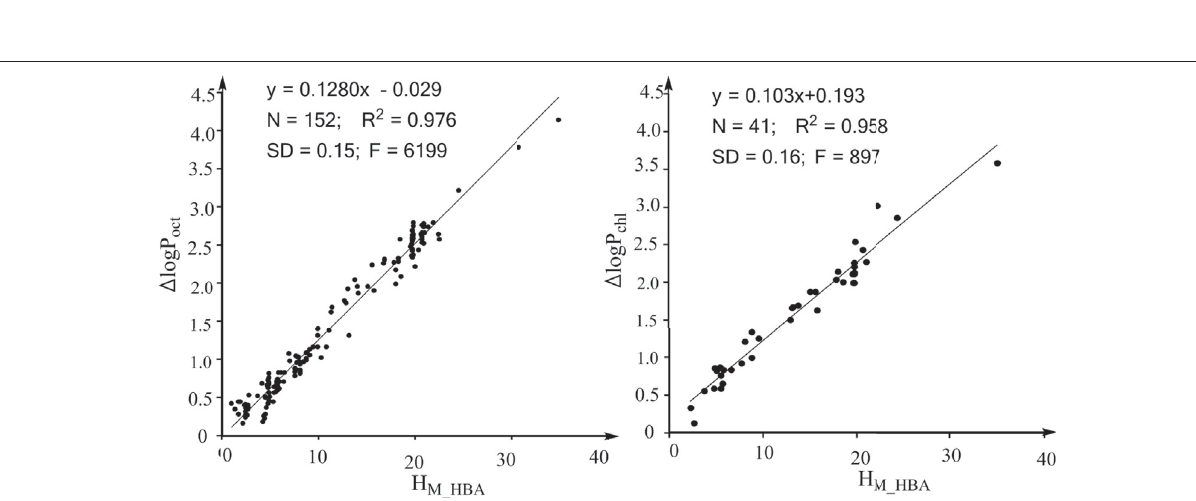
FIGURE 1 | Correlations between the molecular descriptor S m and the effects of molecular size on various properties. (A) Linear associations between logP 16 / logP oct and S m for alkanes. (B) Linear association between logK brain (log of the partition coef fi cient from air to human brain) and S m for nonpolar compounds. (C) Plot of the water to hexadecane phase-transferring free energy for depolarized solutes ( Δ G tr_depol ) against the S m values of the solutes.